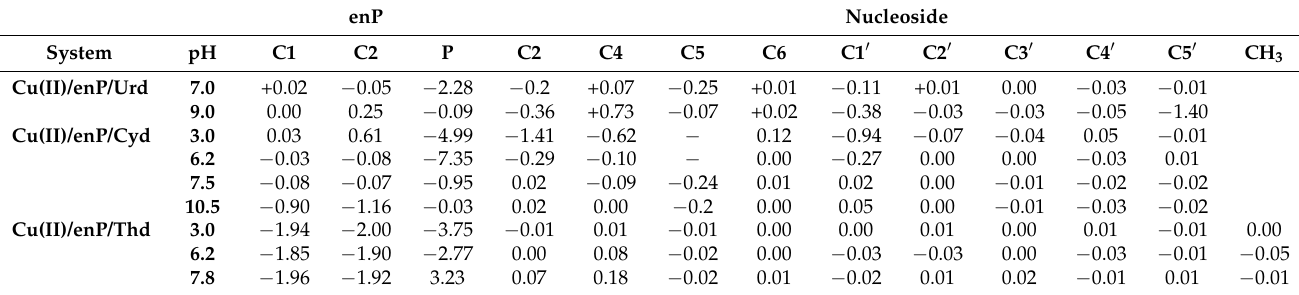
Table 9. NMR differences between signal positions for the ligand in the complex in relation to the free ligand (ppm). enP Nucleoside